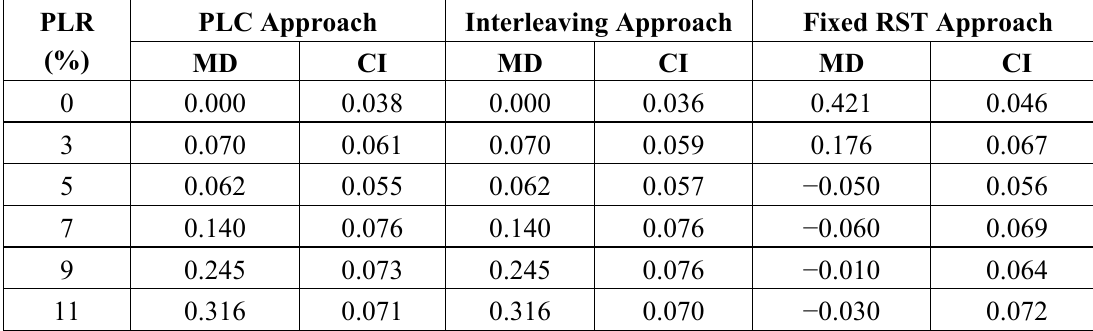
Table 2. Statistical test results of the ARST approach against each of the compared approaches such as PLC, interleaving, and fixed RST approach under different PLRs ranging from 0% to 11%, where MOS difference (MD) and confidence interval (CI) for each PLR condition were also